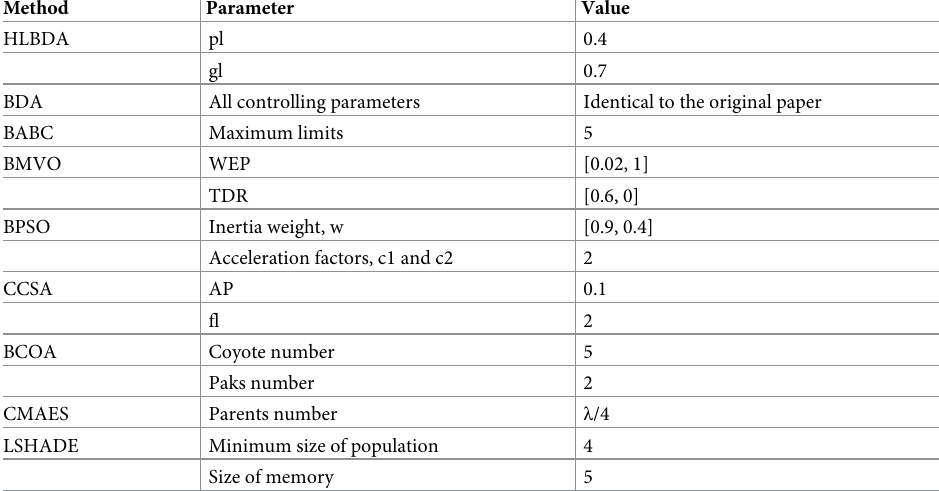
Table 8. Control parameter settings for comparative feature selection